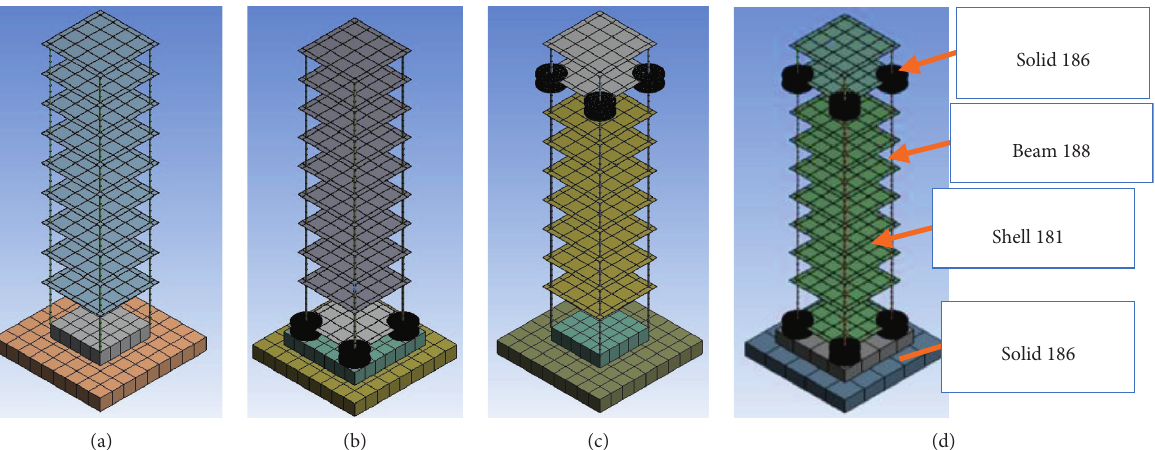
Figure 7: Finite element models of the structure FPS isolation system. (a) Primary structure. (b) FPS base isolation structure. (c) FPS inter- storey isolation structure. (d) FPS dual isolation